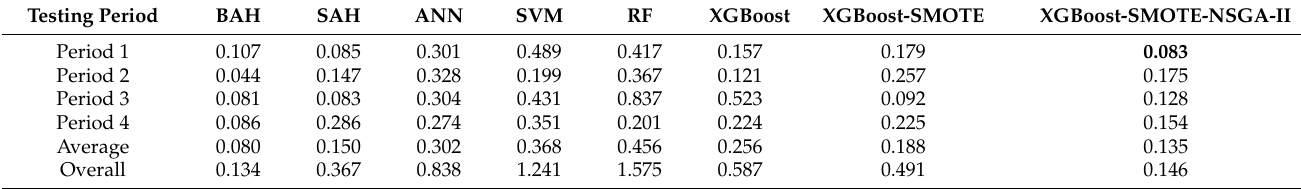
Table 8. Maximum drawdown results of all methods for simulation trading.